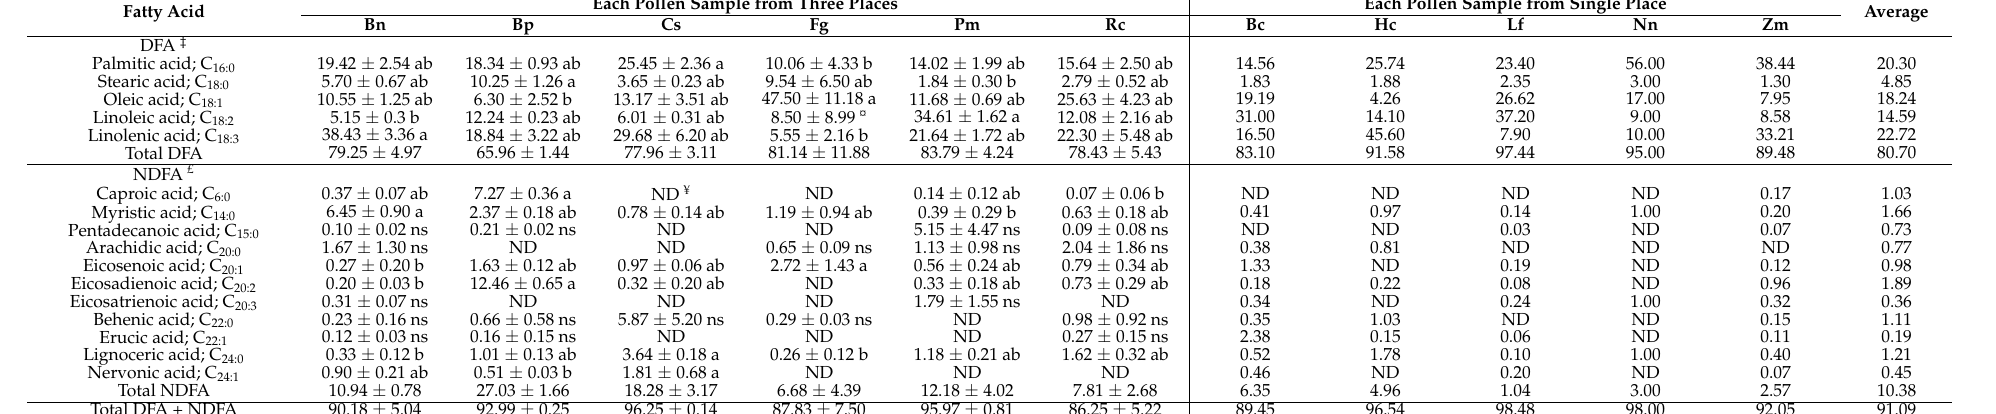
Table 5. Fatty acid composition of bee pollen samples †